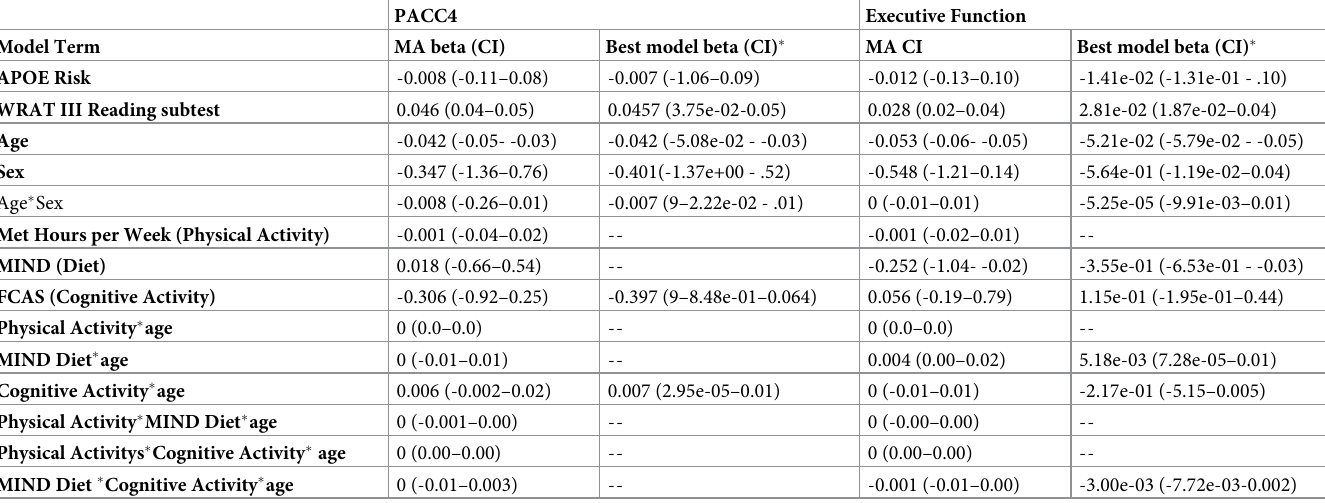
Table 4. Beta estimates and 95% confidence intervals for best fitting models � relative to their model-averaged parameter